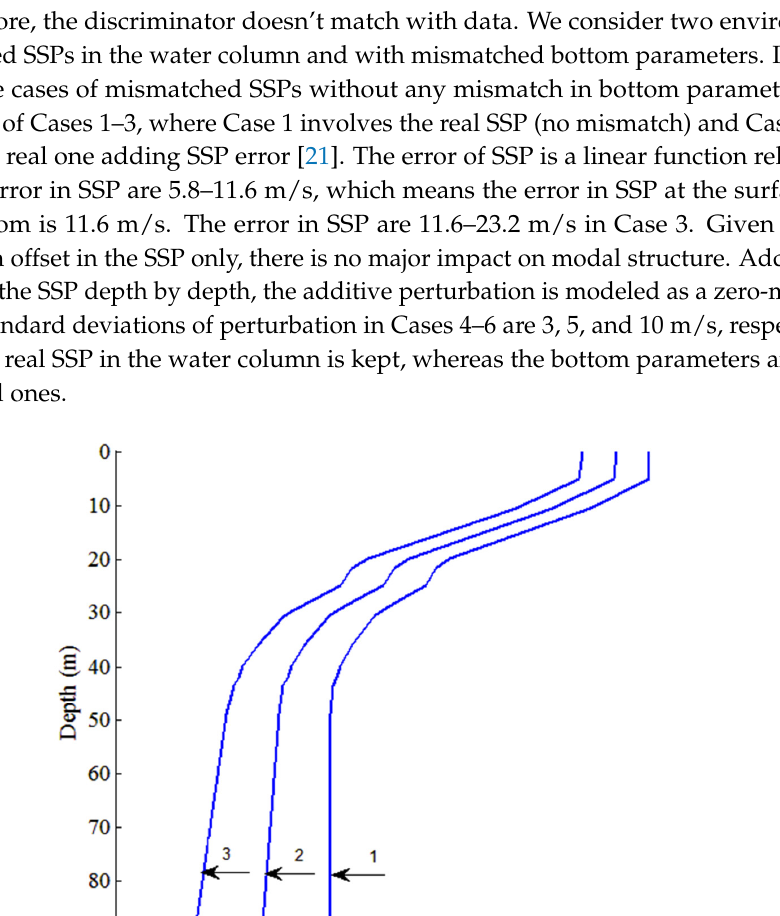
Table 1. Probability of correct discrimination (PCD) in different mismatched environments. SSP Error